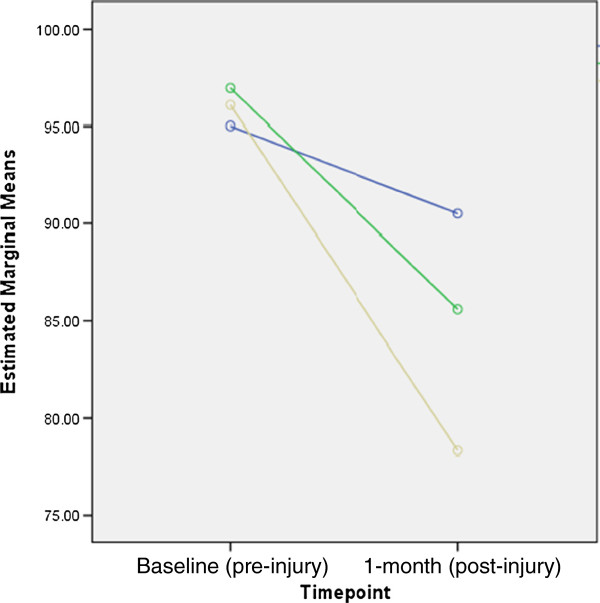
Estimated marginal means of EQ-5D-3 L VAS scores at baseline and 1 month post injury. Figure legend, Length of stay: “Blue circle symbol”: not admitted; “Green circle symbol”: 1–3 days in hospital; “Dark yellow circle symbol”: 4 or more days in hospital.